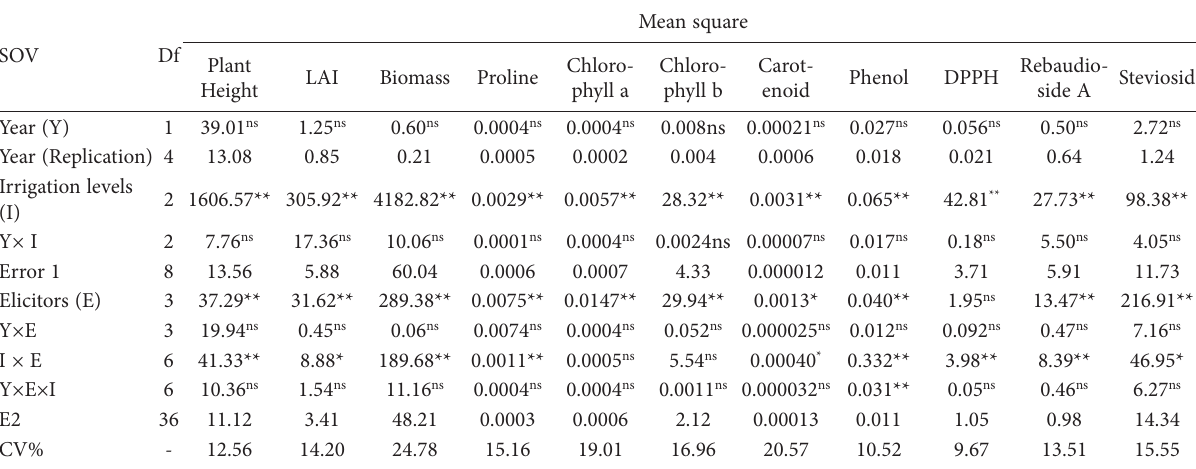
Table 2. Combine analysis of variance of irrigation and spraying elicitors on studied traits in stevia ( Stevia rebaudiana Bertoni ).